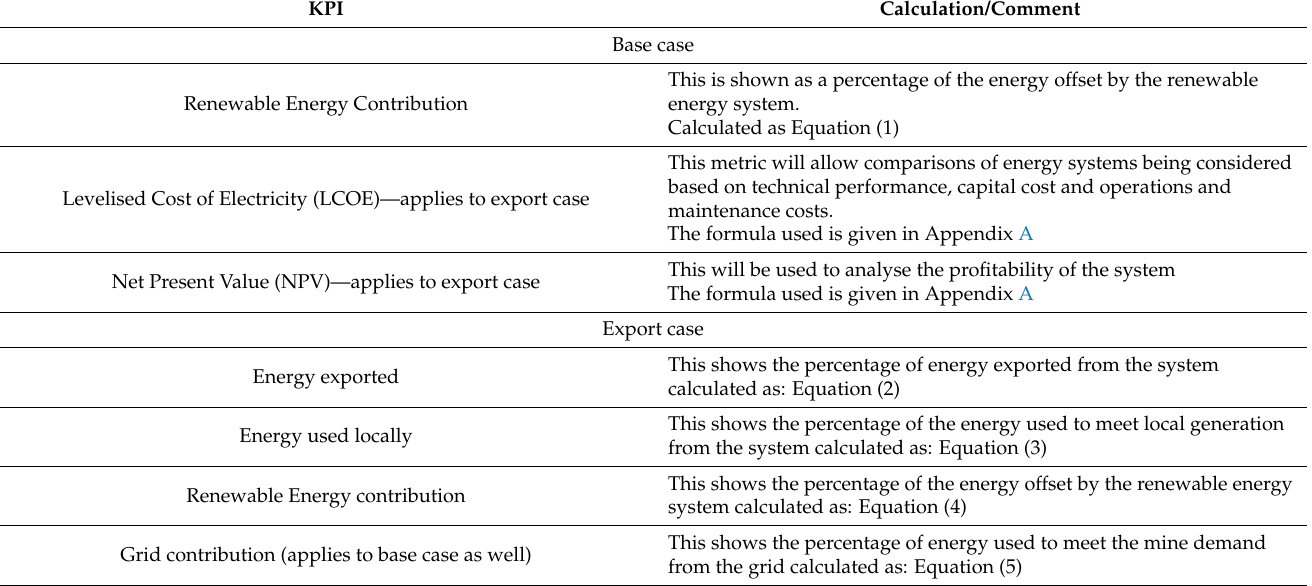
Table 4. Key performance indicators used for